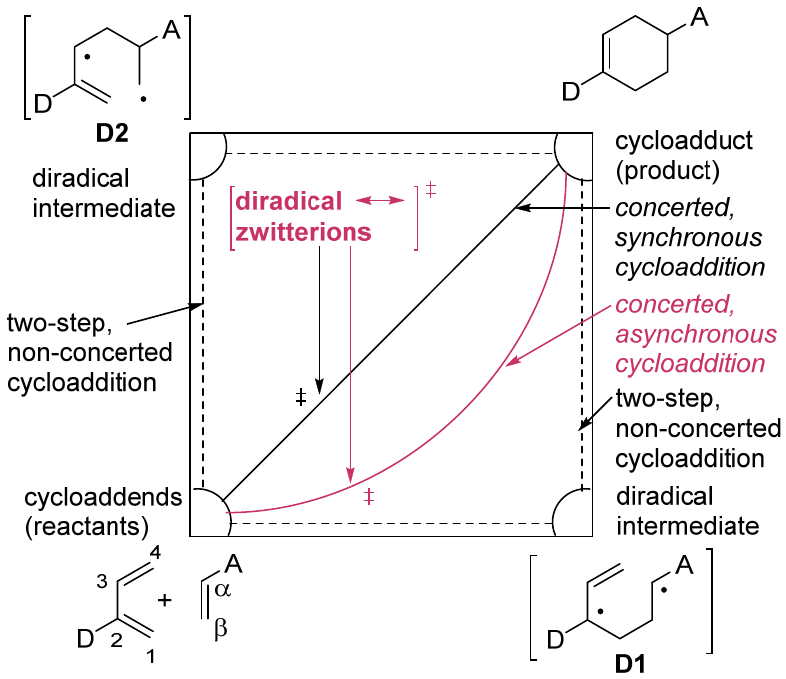
Figure 2. Spectrum of mechanisms for the Diels already Alder reaction. In polar medium and for polar substituents, the diradical intermediates D1 and D2 can be zwitterions. ‡ for transition states. Thermochemical data tell us that the preferred diradical intermediate is the one for which the substituents stabilize the radicals the best, and this implies, as a rule, that this diradical results from combining the least substituted centers of the diene and dienophile. In other words, the most stable isomeric diradical intermediate is the one that has generated the strongest bond between the two reactants (for instance D1 or D1’ , Figure 3). Since many Diels − Alder reactions have measured activation enthalpies ∆ ‡ H that are lower than the enthalpy difference ∆ r H ◦ between the diradical and the cycloaddends, the difference ◦ − ∆ ‡ H can be taken as Doering’s energy of concert (Figure 3). The transition state of ∆ r H such reactions can be readily described in terms of frontier molecular orbital interaction theory [77,78]. An alternative valence-bond representation is that transition structures can be represented by diradicaloids, i.e., diradicals that exchange electron between the two radical entities. Within the valence bond theory, this electron exchange can be represented by a (Z)-diradical and one or two zwitterions, as shown in Figure 3 with